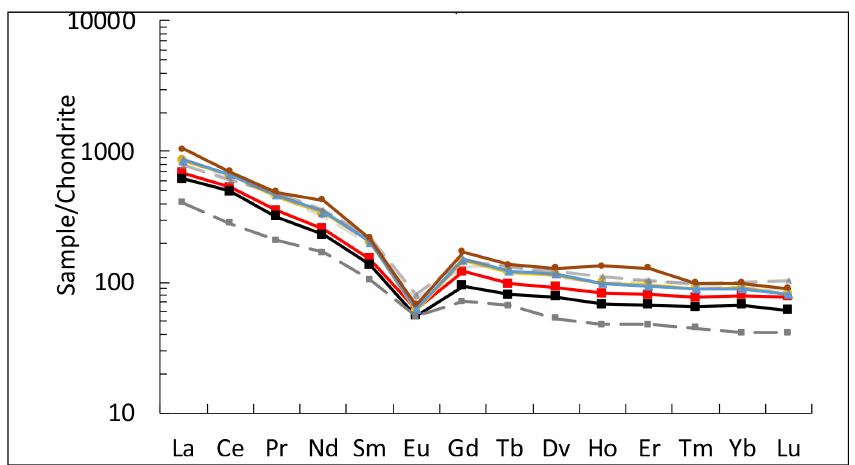
Figure 9: Rare Earth Elements distribution in the chondrite-normalized plot (C1 chondrite normalization values from McDonough & Sun, 1995). As in the major and trace elements diagrams of Figures 7 and 8, SLV and BDT samples are in almost total overlap. Legend as in Figure